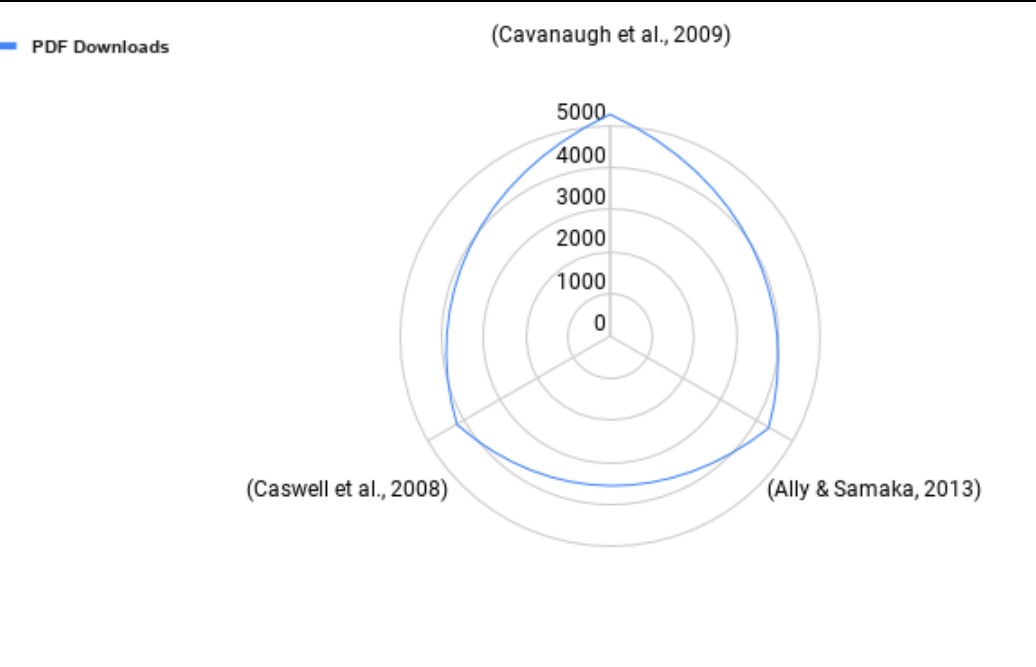
The Top Three OER Articles in the IRRODL by PDF